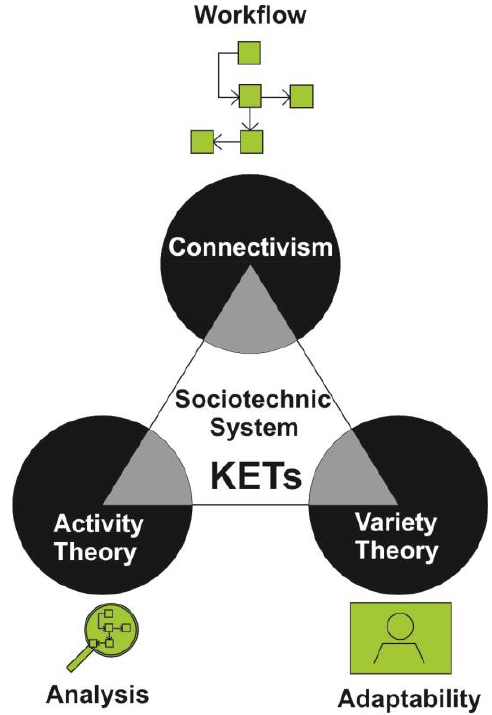
Figure 4. Conceptual frameworks that configure DfHFinI4.0.